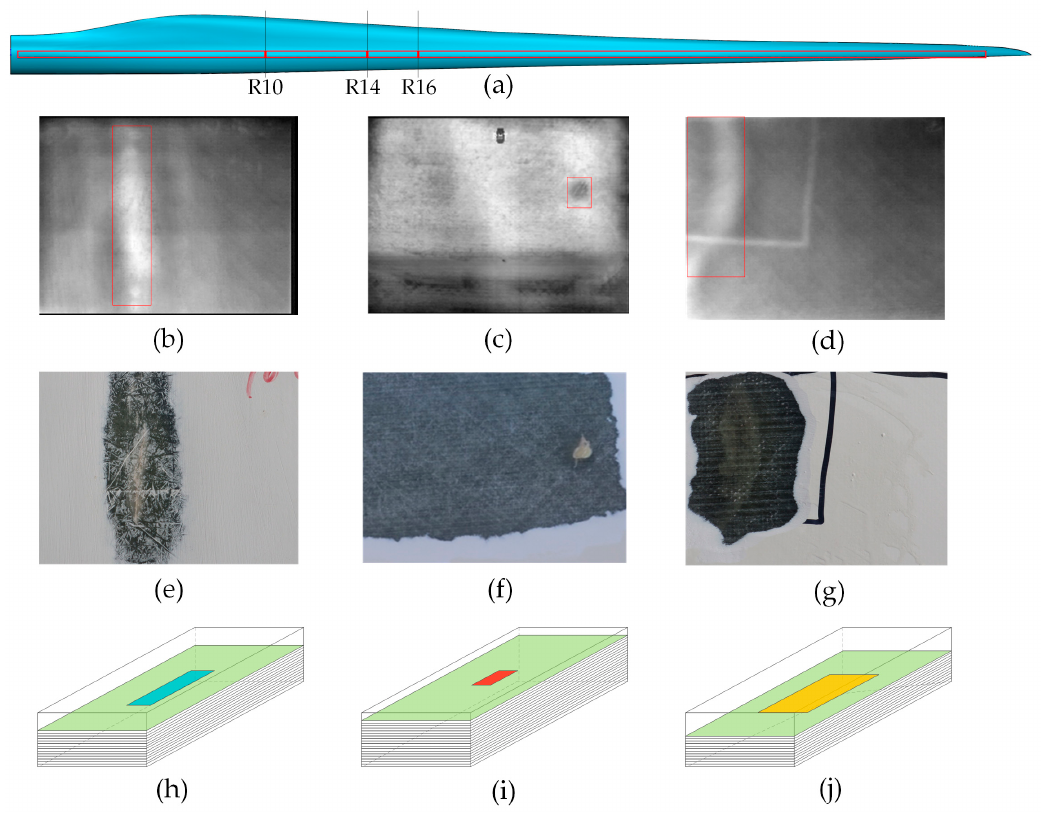
Figure 3. Delamination damage experienced by in-service blade spar cap: ( a ) location of detected delamination damage in the blade spar cap; ( b ) infrared thermal image at R10; ( c ) infrared thermal image at R14; ( d ) infrared thermal image at R16; ( e ) optical image after polishing at R10; ( f ) optical image after polishing at R14; ( g ) optical image after polishing at R16; ( h ) schematic diagram of R10; ( i ) schematic diagram of R14; ( j ) schematic diagram of R16.